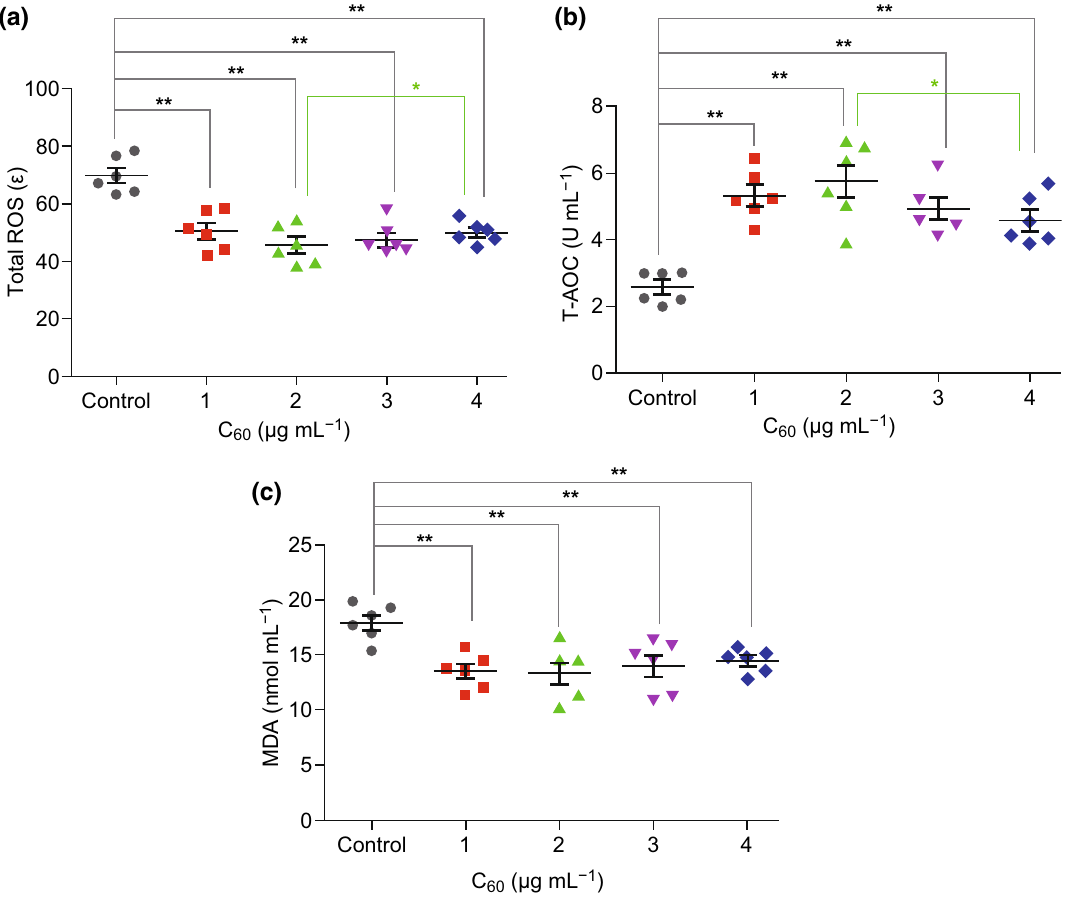
Fig. 2 Dot plots of the tROS level, T-AOC activity, and MDA content, and ATP levels in the control and treatment groups after 15 days of treat- ment. a tROS level, b T-AOC activity, c MDA content ( n = 6, * P < 0.05, ** P <